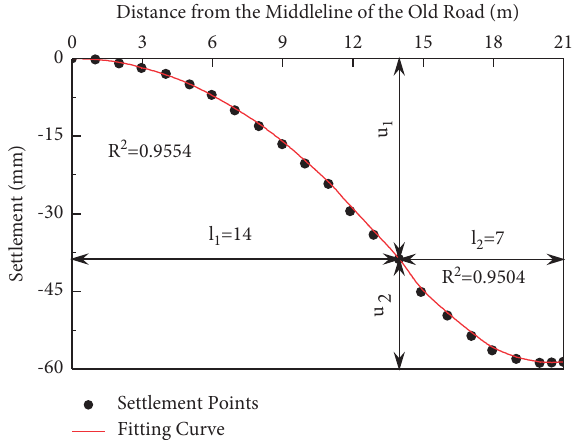
Figure 13: Settlement and fitting curve of the top surface of the